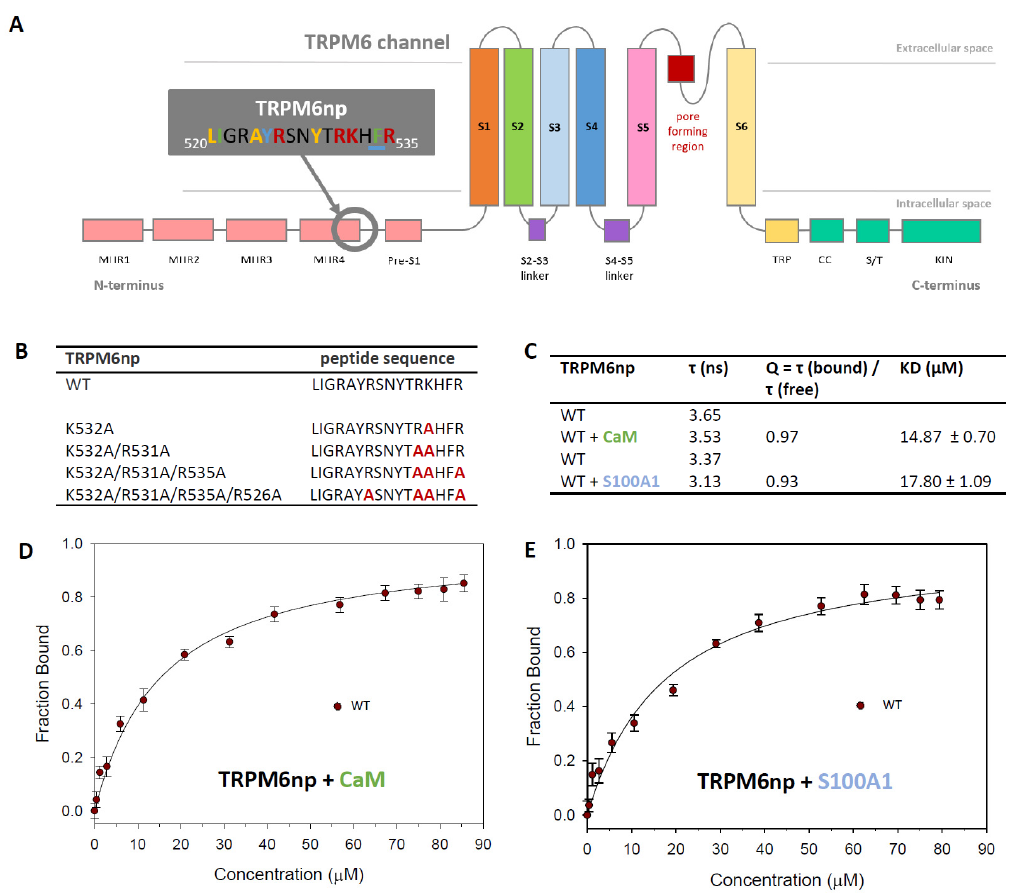
Figure 1. TRPM6np binding domains for CaM and S100A1: ( A ) Schematic representation of the TRPM6 channel. TRPM6 is composed of six transmembrane domains (S1–S6), a pore region between S5 and S6 with a pore helix, and intracellular N- and C-termini. The individual domains are labelled by di ff erent colours. The TRPM6 scheme (according to TRPM7 structure) presents the N-terminal tail with four melastatin homology regions (MHR 1–4) and pre-S1 domain. The TRPM6 C-terminus is composed of TRP, coiled-coil (CC), Ser / Thr (S / T), and kinase (KIN) domains. Predicted CaM and S100A1 binding domain in the grey box shows the TRPM6np sequence (L520-R535) containing several CaM recognition hydrophobic motifs (Y525-F534 (1–10 motifs) highlighted in blue, L520-A524-Y529 (1–5–10 motifs) highlighted in yellow, and I521-F534 (1–14 motifs) highlighted in green). TRPM6np basic amino acids (highlighted in red) represent a cluster of amino acids potentially involved in the interactions with CaM and S100A1. ( B ) TRPM6np amino acid sequences of wild type (WT) and mutated analogues used for the investigation of CaM and 100A1 binding site (substitutions of R / K for Figure 1A highlighted in red). The TRPM6np binding a ffi nity to CaM and S100A1 was investigated by the steady-state fluorescence anisotropy method. This technique is based on measurement of the changing orientation of a molecule